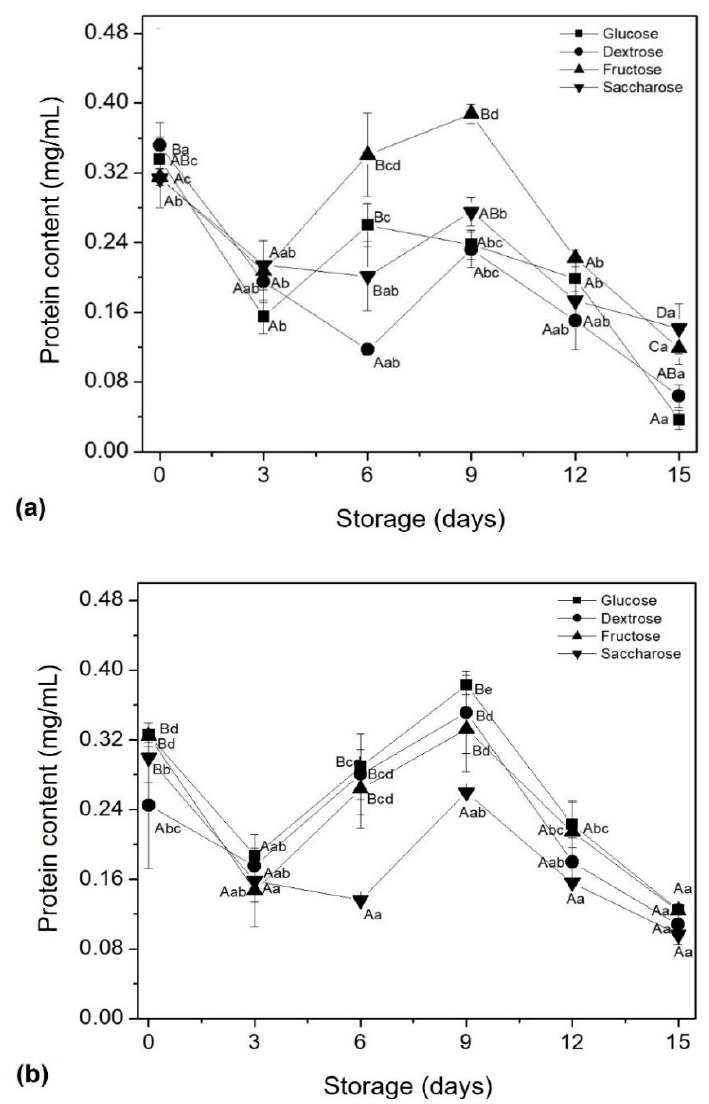
Figure 2. Protein content of kombucha fermentations ( a ) COr and ( b ) CFr stored at 25 °C for 15 days. Mean ± standard deviation. Letters (A, B, C) indicate significant differences between carbon sources by day, and letters (a, b, c) indicate a significant difference for the same carbon source during storage.